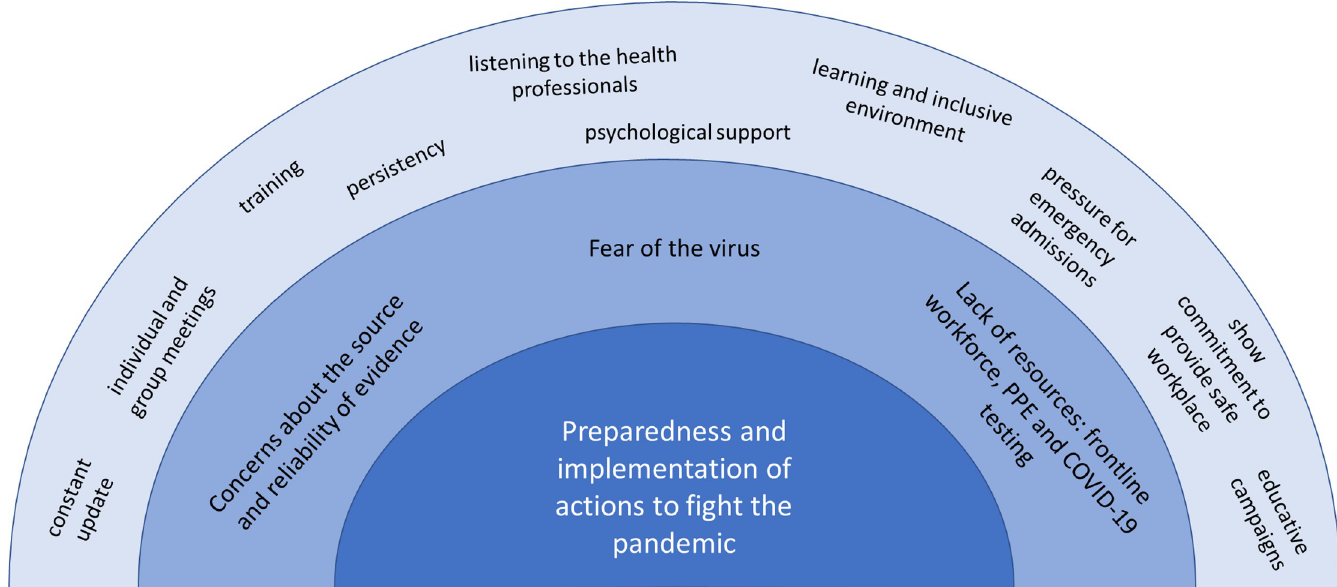
Fig 4. Framework of the conflicts, experiences and response actions on the preparedness and implementations of actions to fight the pandemic according to the health managers. The middle layer shows the conflicts and the outer layer demonstrates the main actions performed by the health managers and institutions to tackle the main